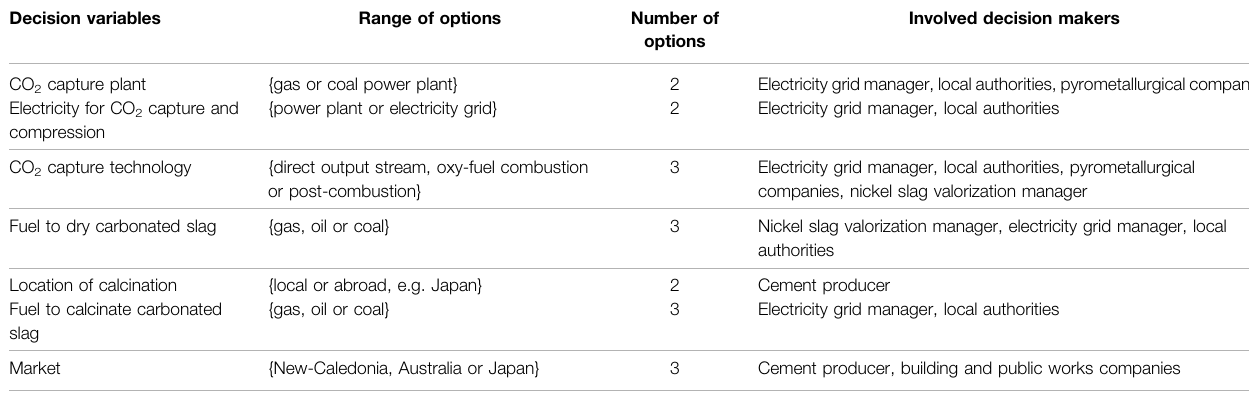
TABLE 1 | Decision variables set for creation of the nickel slag valorization sector by mineralization of New-Caledonia. Decision variables